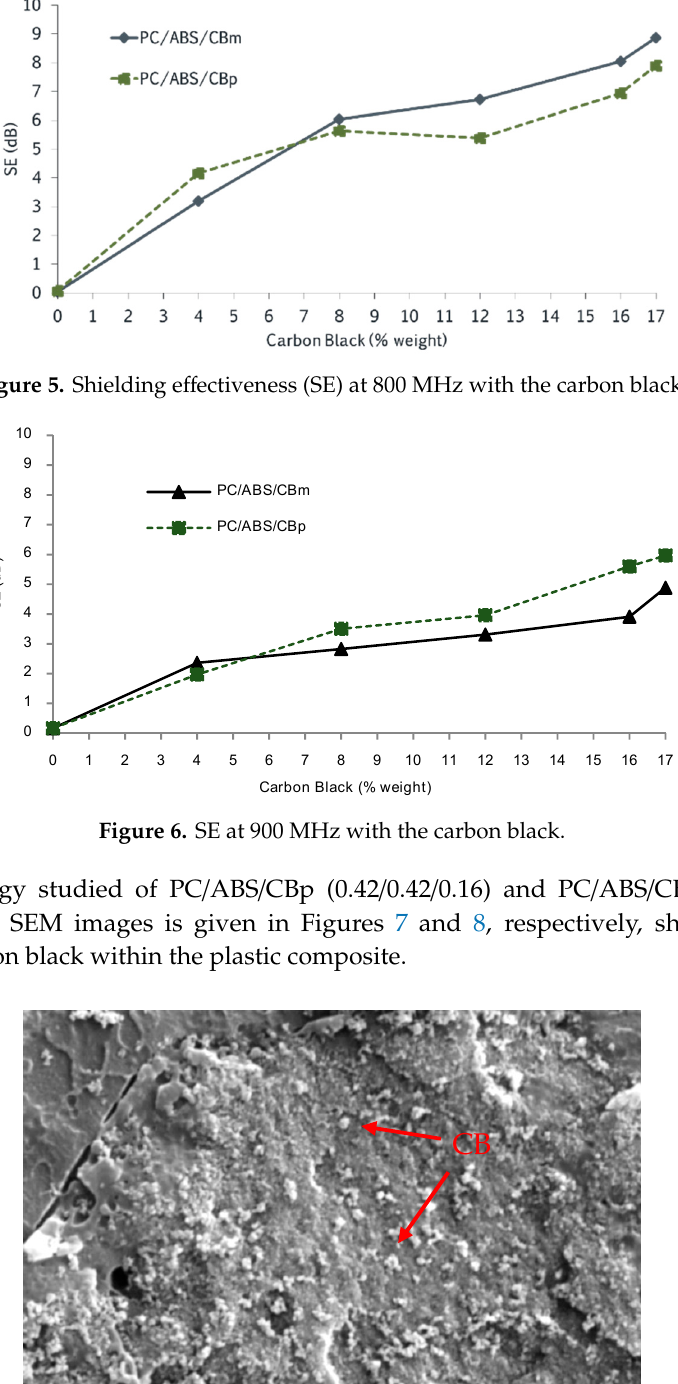
Figure 7. SEM image of the 16 wt % carbon black powder (CBp) in the PC/ABS.